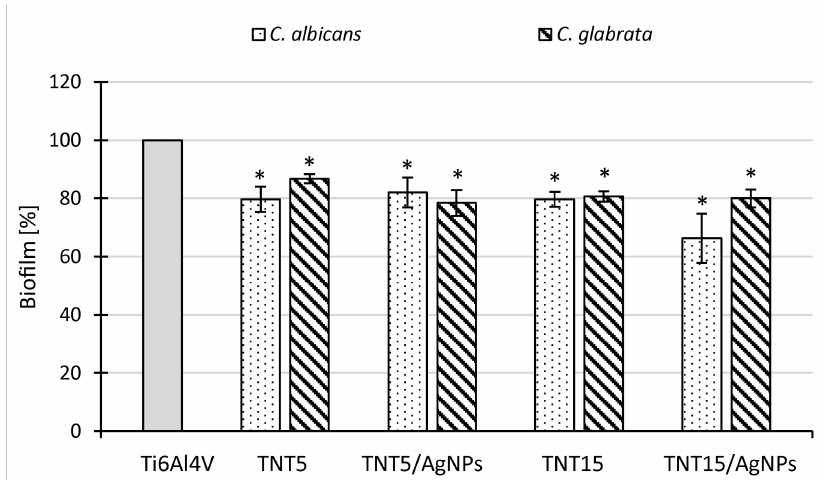
Figure 8. Fungal biofilm on TNT- and TNT / AgNPs-modified Ti6Al4V surfaces assessed using FDA (fluorescein diacetate) staining. The results are presented as the mean percentage ± standard deviation (SD) of the fungal biofilm formed on the tested layers compared to a control biofilm formed on the reference biomaterial (Ti6Al4V) considered as 100%. Statistical analysis was estimated with nonparametric Kruskal–Wallis one-way ANOVA test (* significant di ff erences, p <